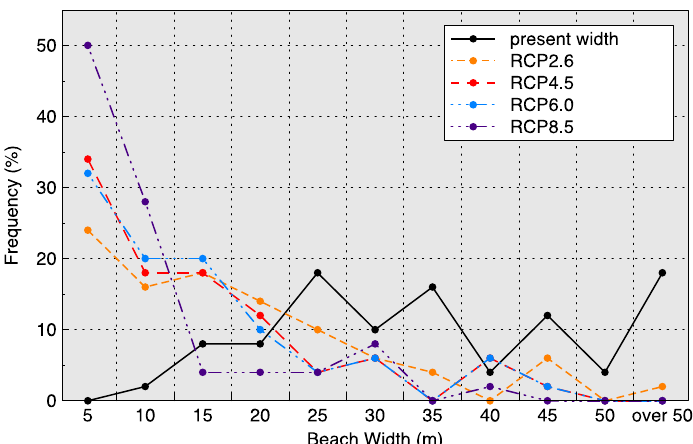
Figure 2. Beach width at ( a ) the present condition ( b ) the Future (2080–2100) projections based on 4 RCP scenarios adapted from the results of beach loss projection due to SLR by Ritphring et al. study [10] in which the calculation was based on the Bruun rule assumption.